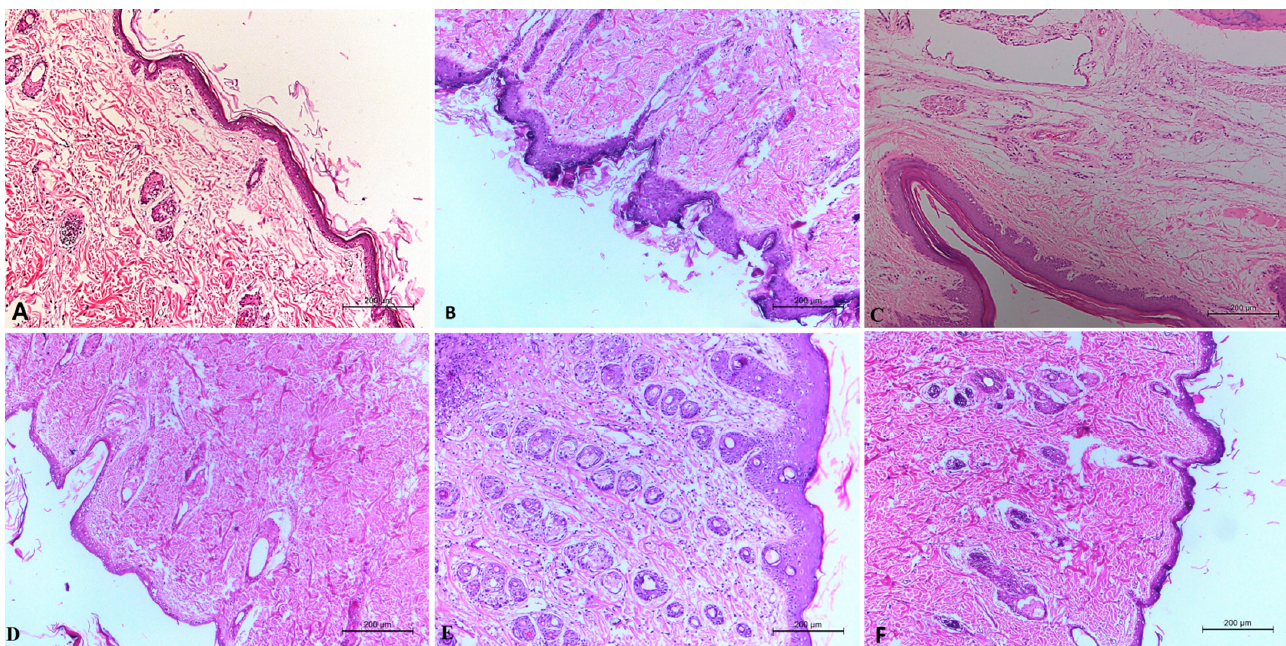
Figure 7. Histolopathological evaluation of negative control group ( A ), DMBA control ( B ), free tamoxifen suspension ( C ), free amygdalin solution ( D ), plain niosomes gel ( E ), and optimum ALN gel ( F ).